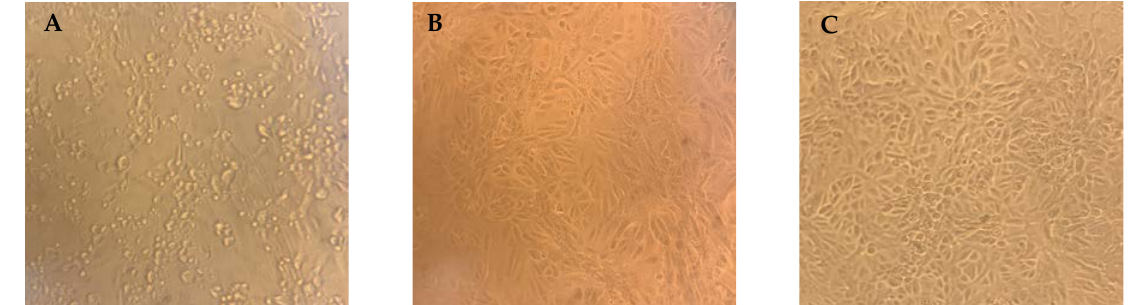
Figure 2. Viral cytopathic effects (CPE) of SARS-CoV-2 on Vero cells and neutralizing antibody activity. ( A ) Non-protective serum showing lysed cells due to viral replication (absence of neutralizing antibodies); ( B ) protective serum at low dilution of 1:10, showing inhibition of CPE by specific neutralizing antibodies; ( C ) highest serum dilution of 1:320 that protected cells from CPE taken as the neutralizing antibody titer.